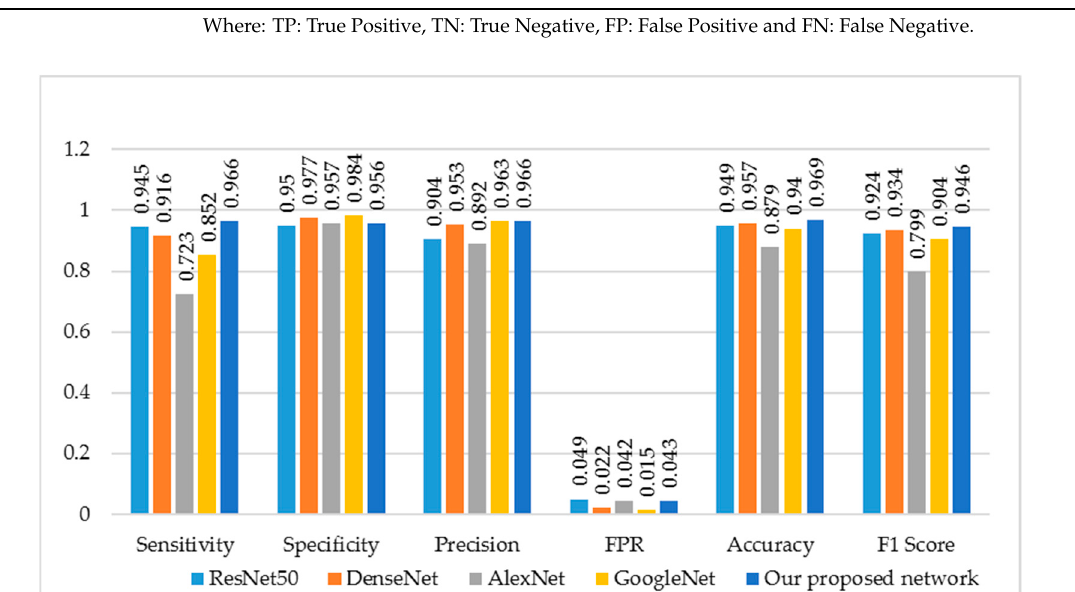
Table 3. Comparison between our proposed network and other pre-trained CNN models in terms of time execution and power consumption. ResNet50